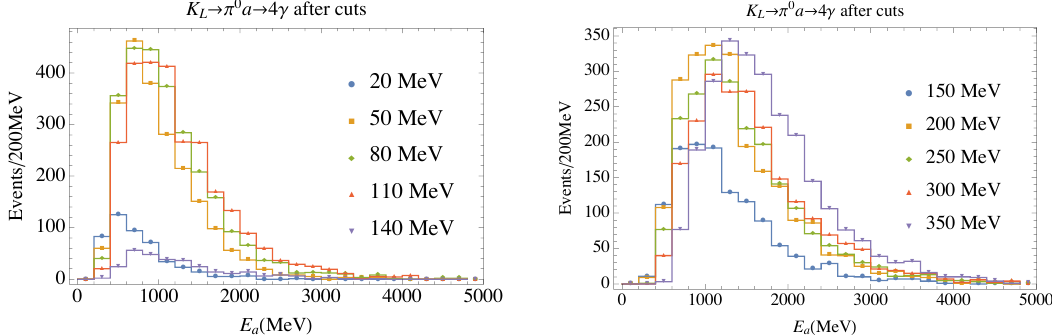
Figure 6 . Distribution of the energy of the ALP produced in K L ! (cid:25) 0 a decays for di(cid:11)erent ALP masses after cuts. The original MC sample size is 5 (cid:2) 10 4 , and the di(cid:11)erent normalization of the several curves indicate the di(cid:11)erence in the cut e(cid:14)ciency depending on the ALP mass. mean life-time and ( E =m ) is the relevant boost factor, (cid:12)(cid:13) . The ALP energy distribution a a used to compute the boost factor is shown in (cid:12)gure 6 for di(cid:11)erent values of the ALP